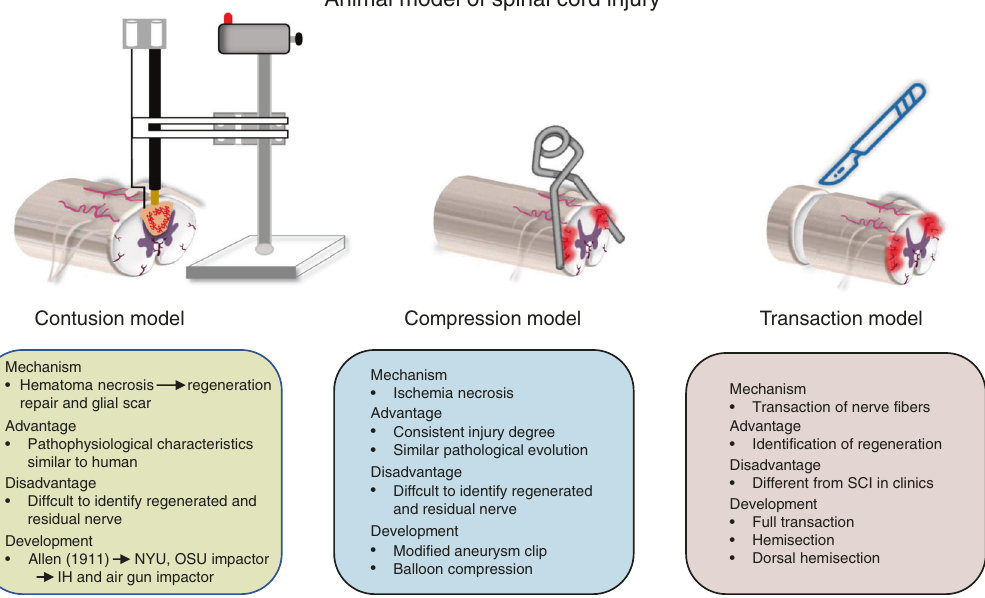
Fig. 1 Animal models of SCI. This fi gure illustrates the mechanisms, advantages, disadvantages, and development of the three SCI animal